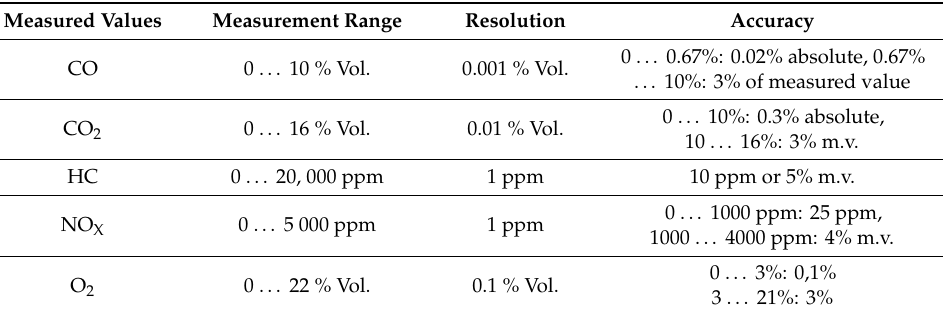
Table 4. Technical parameters of mobile emission analyser.